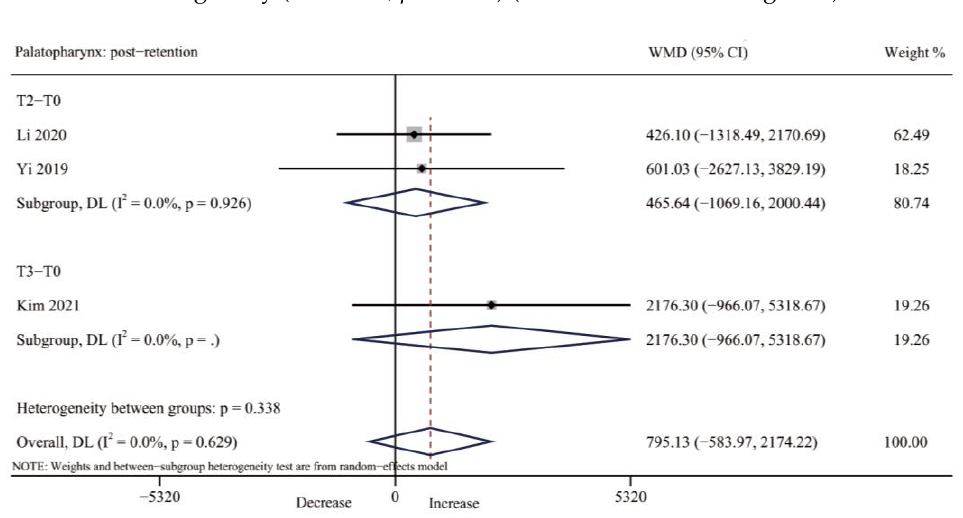
Figure 7. Forest plot for the changes of palatopharynx volume after retention (T2–T3). T0, before expansion; T2, three months after expansion; T3, six months after expansion; WMD, weighted mean difference; CI, confidence interval [32,34,35].